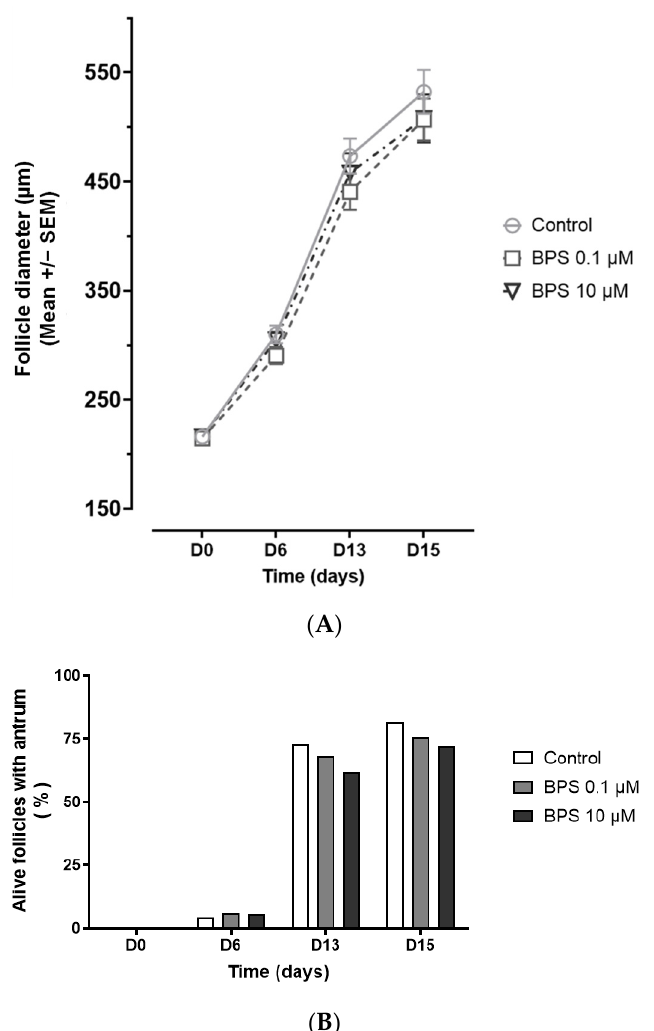
Figure 2. In vitro effects of bisphenol S (BPS) on ovine follicular growth and antrum appearance. The diameter evolution ( A ) and the antral cavity appearance ( B ) for each alive follicle were assessed after 6, 13 and 15 days of treatment with or without BPS 0.1 µ M or BPS 10 µ M. The results are representative of seven independent cultures with eight replicates per condition ( n = 56 per condition at day 0, n = 48–53 according to the conditions at day 6, n = 40–42 according to the conditions at day 13 and n = 38–39 according to the conditions at day 15). For the diameter evolution, the results are expressed as mean +/ − SEM and were analysed with a Brown–Forsythe ANOVA test at each day of measure ( A ). For the antrum appearance, the results are expressed as the percentage of alive follicles with an antrum and were analysed with a logistic regression at each day of measure ( B ). Differences were considered significant when p <